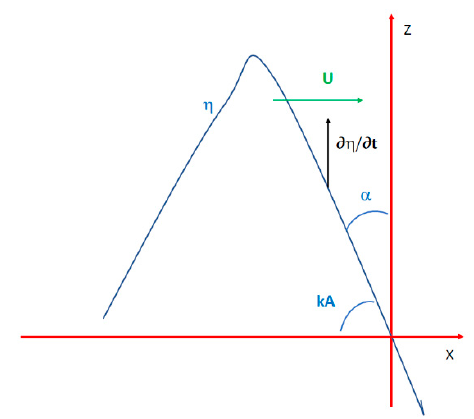
Figure 4. A selection of local wave parameters (based on [21]).